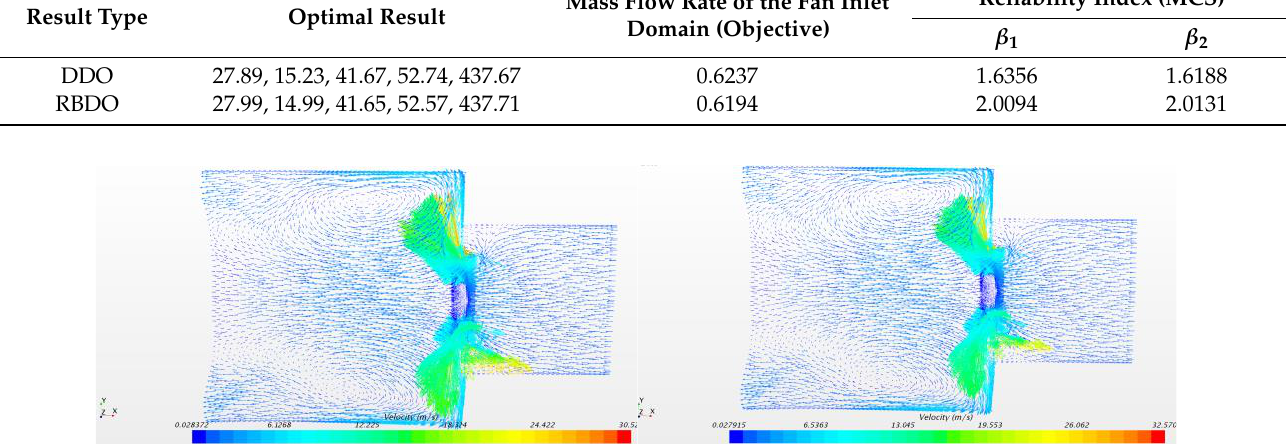
Figure 11. Comparison of the cross-sections in the flow field between the deterministic and reliability optimization results.